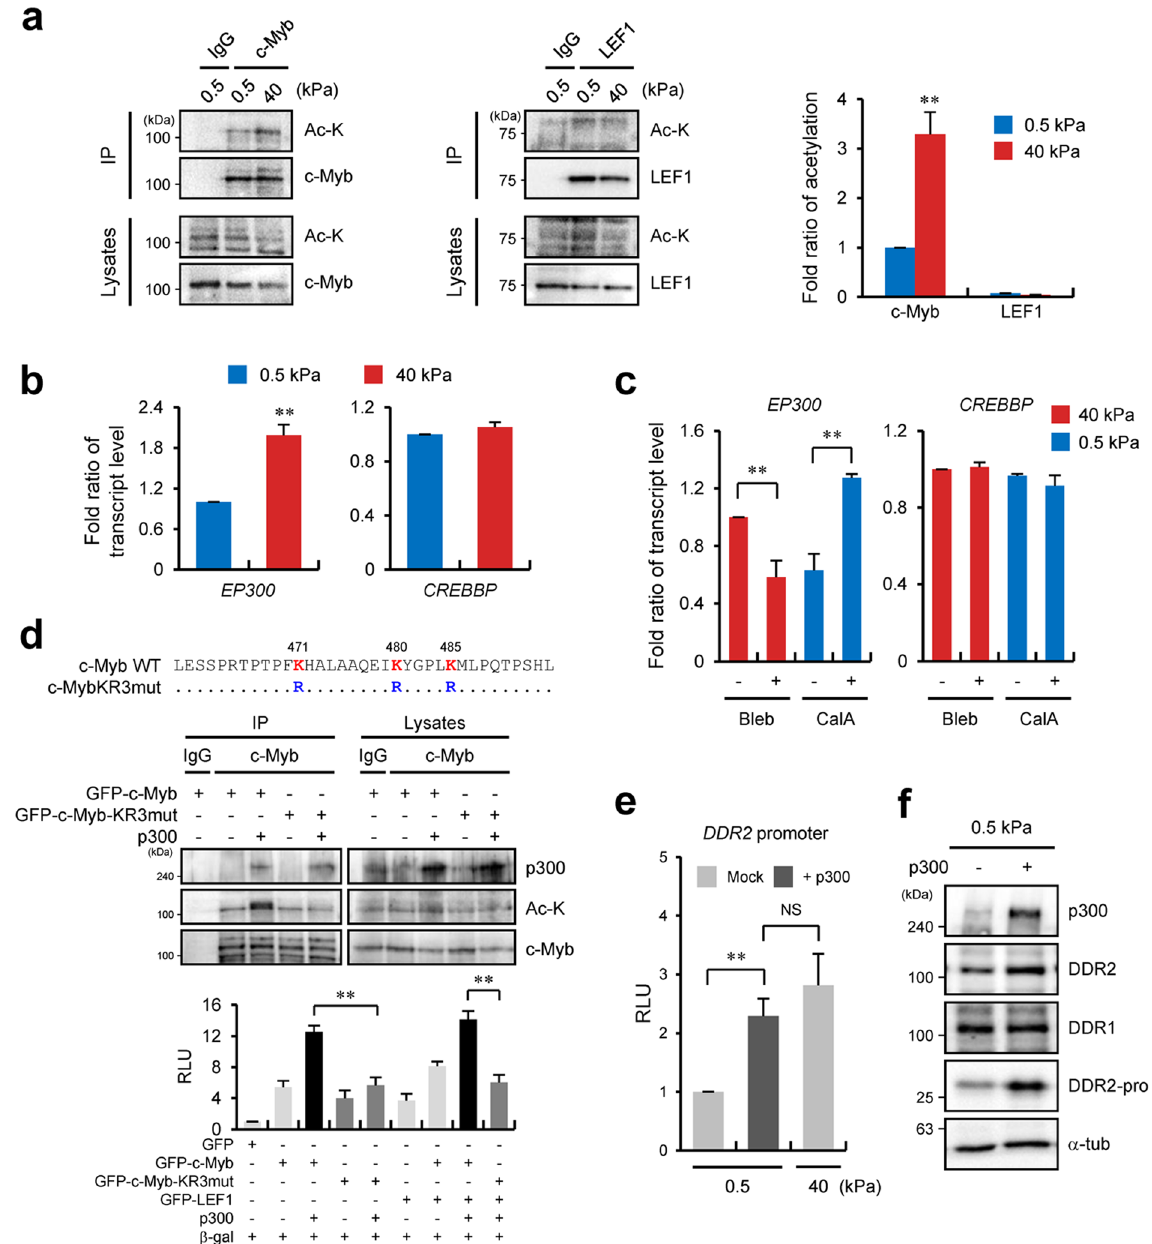
Figure 5. Histone acetyltransferase p300 regulates DDR2 promoter activity via c-Myb acetylation. ( a ) A coimmunoprecipitation assay of lysates from c-Myb- or LEF1-overexpressing HEK 293 T cells using the indicated antibodies under the indicated conditions (left) and quantification of acetylation of c-Myb and LEF1 (right). Labels above and to the right of blots refer to antibodies used for the immunoprecipitation and immunoblotting, respectively. ( b ) qRT-PCR analysis of the expression of EP300 and CREBBP in H1299 cells incubated on a 0.5- or 40-kPa PAG. ( c ) qRT-PCR analysis of expression of EP300 in H1299 cells incubated on a 40-kPa PAG with blebbistatin (10 μ M) or a 0.5-kPa PAG with calyculin A (2.5 nM). ( d ) A partial protein sequence of c-Myb. Conserved lysine residues at positions 471, 480, and 485 are highlighted in red. Arginine residues (blue) denote mutated amino acid residues (top). Coimmunoprecipitation analysis of lysates from c-Myb-, c-MybKR3mutant-, or p300-overexpressing HEK 293T cells using the indicated antibodies. Labels above and to the right of the blots refer to antibodies used for the immunoprecipitation and immunoblotting, respectively (middle). Relative expression of DDR2 WT promoter–driven luciferase reporters in c-Myb-, c-MybKR3mut-, or p300-overexpressing H1299 cells as indicated (bottom). ( e ) Relative expression of DDR2 WT promoter–driven luciferase reporters in mock or p300-overexpressing H1299 cells incubated on a PAG with 0.5- or 40-kPa stiffness. ( f ) Western blot analysis of p300, DDR1, and DDR2 in p300-overexpressing H1299 cells incubated on a PAG with 0.5-kPa stiffness. DDR2-pro refers to GFP under the control of the DDR2 WT promoter. Data in ( a ), ( b ), ( c ) and ( e ) represent the mean of three independent experiments ± SEM. NS, non significant. ** P <